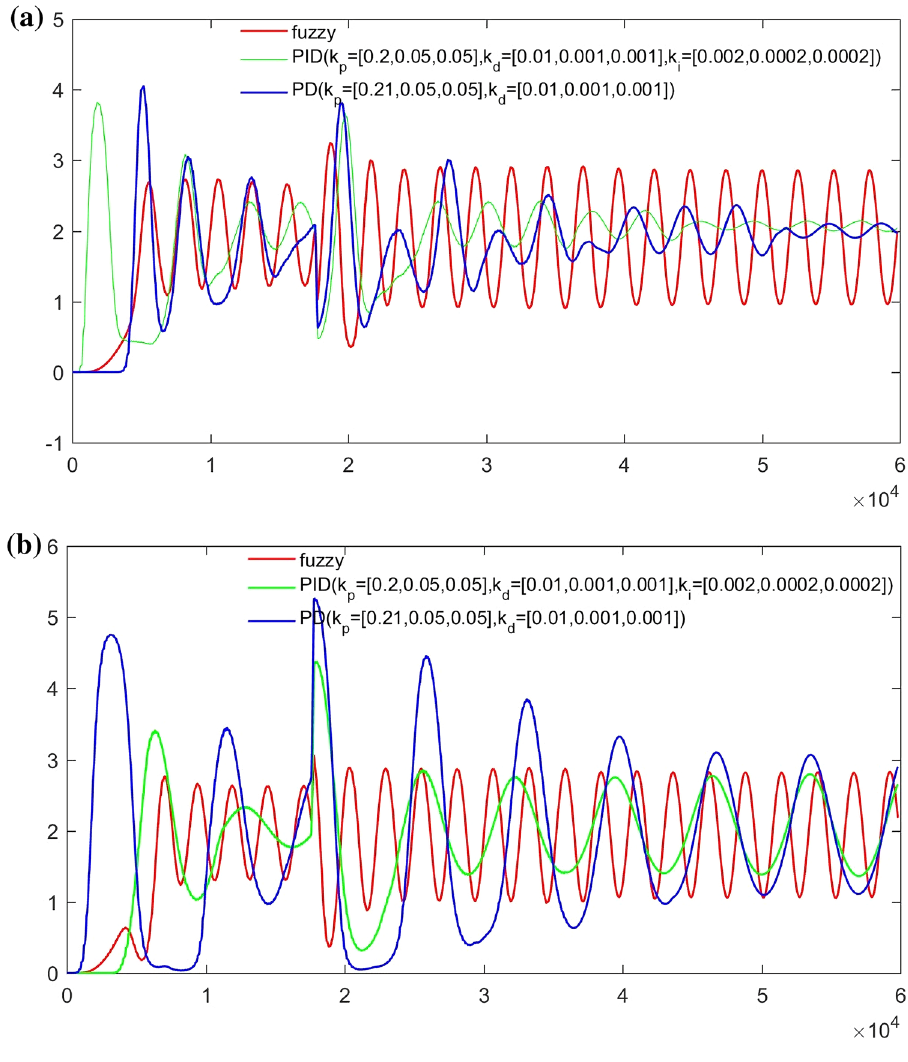
Figure 19. Under the change of switch time θ = 178 s → 182 s